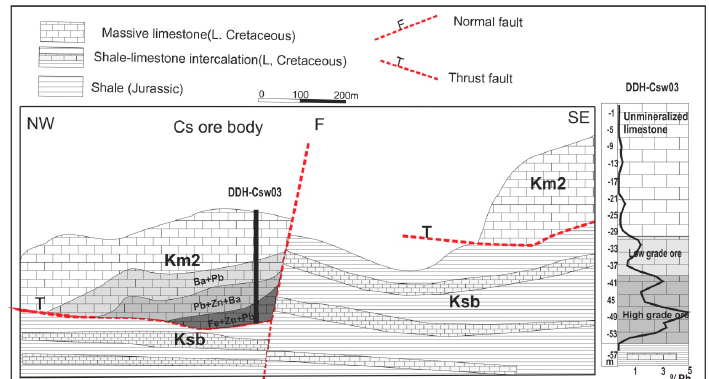
Figure 3. Schematic cross sections of the Cs ore body of the Ravanj deposit. Change in content of Pb (%) from the bottom to top of the massive limestone in the Csw03 drill hole (data from the Soojmiran Co. drill core loges). Minerals 2017 , 7 , x FOR PEER REVIEW